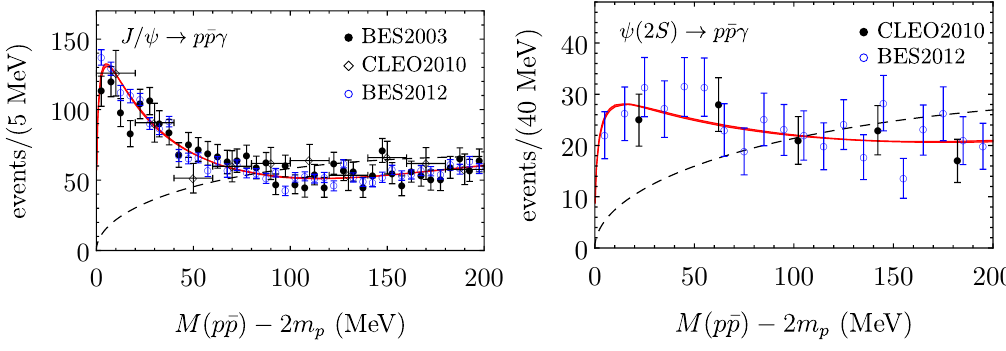
Figure 5. Left picture: J /ψ → p ¯ p γ decay; right picture: ψ (2 S ) → p ¯ p γ decay. The phase space behavior is shown by the dashed